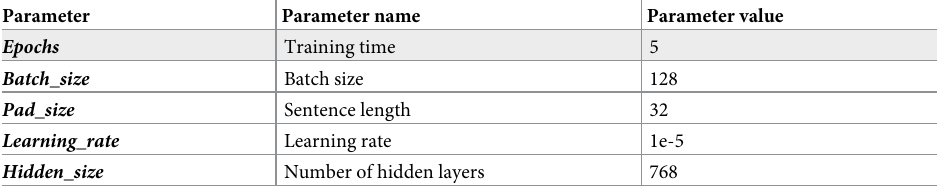
Table 2. Parameter configuration